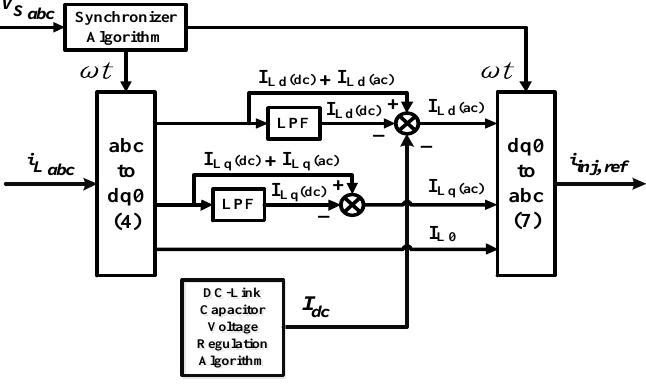
( b ) Figure 1. The proposed three-phase three-level NPC inverter-based SAPF: ( a ) circuit diagram, and ( b ) control strategies. Meanwhile, the minimum capacitance value 𝐶 𝑑𝑐 for each capacitor can be determined as follows [36–39]: